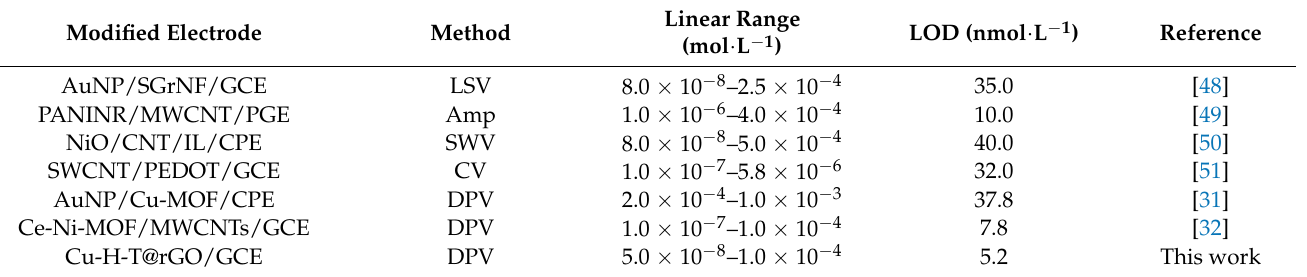
Table 1. Comparison of the performances of the BPA sensors fabricated in the literature and this work.